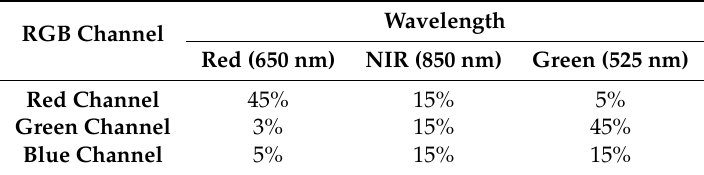
Table 2. Estimated quantum efficiency of camera